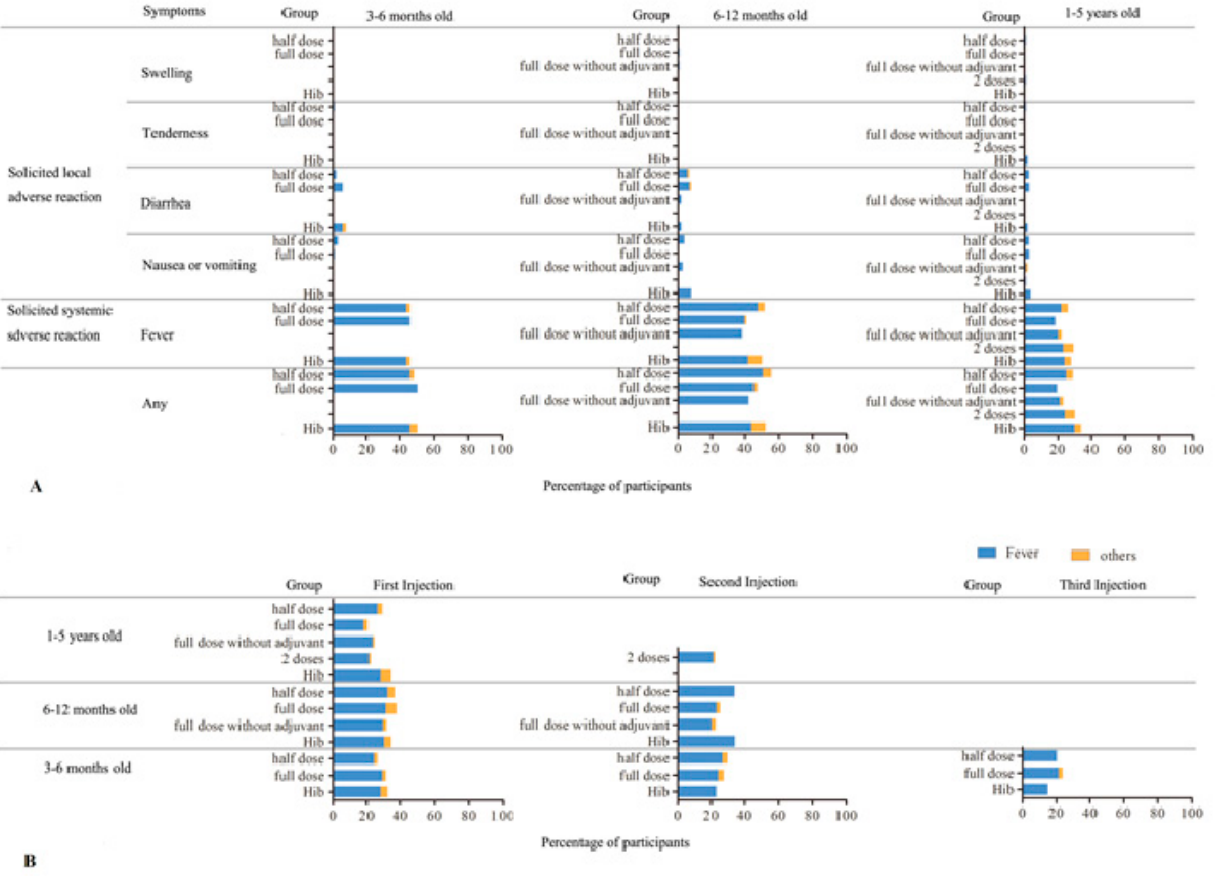
Figure 2. Incidence rate (%) of adverse reactions related to vaccination reported within 30 days after any injections. ( A ) Combined incidence rate according to ages. Blue bars indicate mild/moderate reactions and orange for grade 3 reactions. There was no statistical significance within the same age group receiving any type or number of vaccine injections or between any age groups ( p > 0.5). ( B ) Comparison of the rate (%) of adverse reactions according to the number of injec ‐ tions and vaccine types. Blue bars indicate fever incidences and orange, for other adverse reactions. There was no statis ‐ tical significance in the incidence rate between number of injections within the same age group, with or without adju ‐ vant, full, or half dosages ( p >